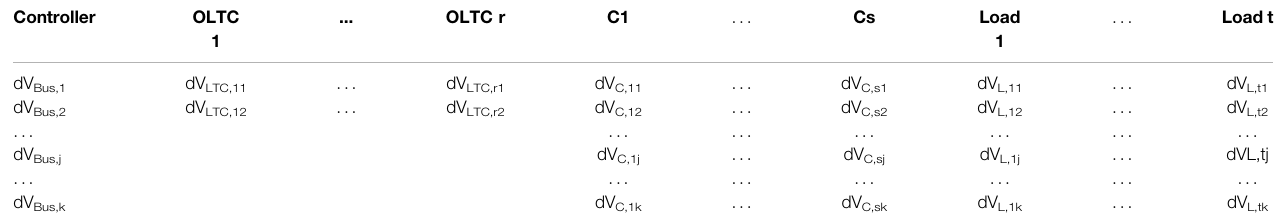
TABLE 2 | Emergency mode.